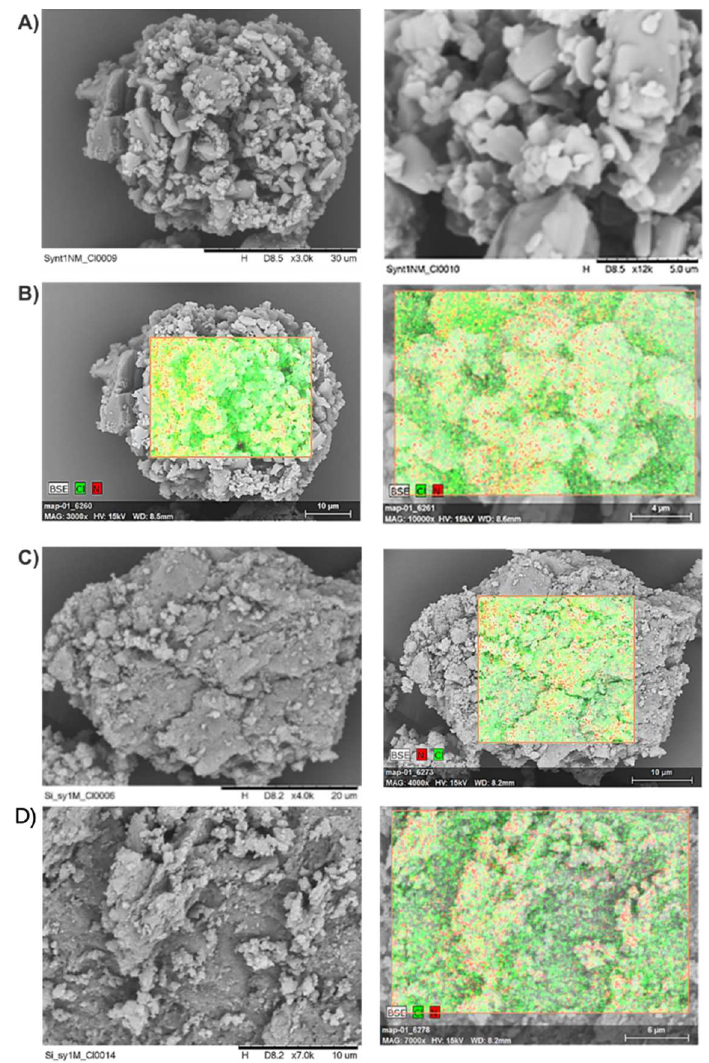
Figure 5. SEM images of the carriers A and D coated with chloramphenicol: ( A ) unground, coated carrier; ( B ) EDS mapping of unground, coated (A_ClPh); ( C ) ground, coated carrier; and ( D ) EDS mapping of ground, coated (D_ClPh).